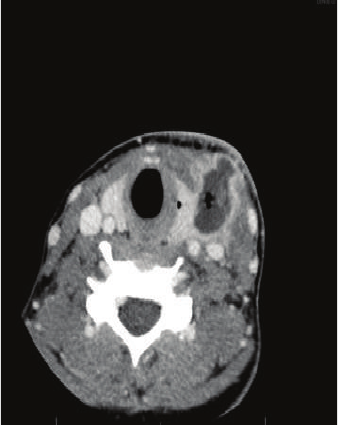
Figure 1: Axial view CT-scan.